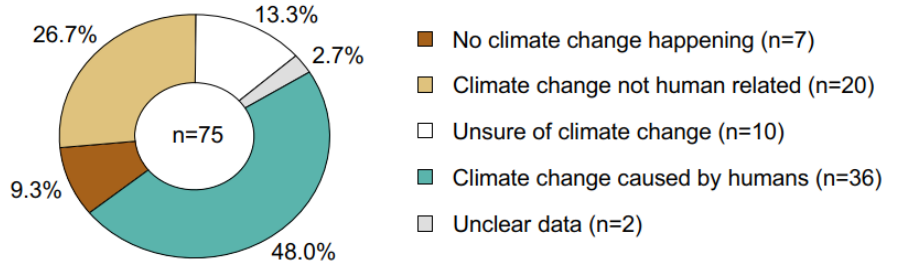
Figure 1. Climate change belief categories of participants driving for TNCs (Transportation Net- work Companies). Table 2. Reasons for climate change (dis)-beliefs and disbeliefs among participants driving for TNCs (Transportation Network Companies). number of participants: n =